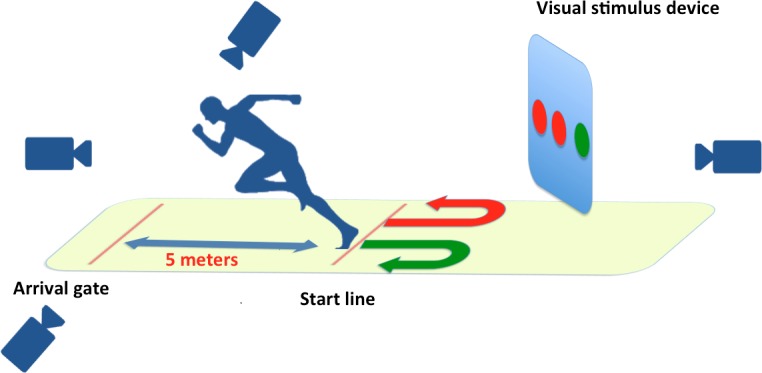
Equipment set up for the agility test. The device showed the side of the rotation: when the left light turned red, the player performed a left rotation and conversely when the right light turned red, the player performed a right rotation. When the center light turned red, the player chose the preferable side to turn. The device was seated on a tripod with adjustable height, therefore each test was arranged at the player’s eye level. To achieve the agility test, the player had to execute a 180° turn and run as fast as possible to the arrival gate placed 5 m behind him.